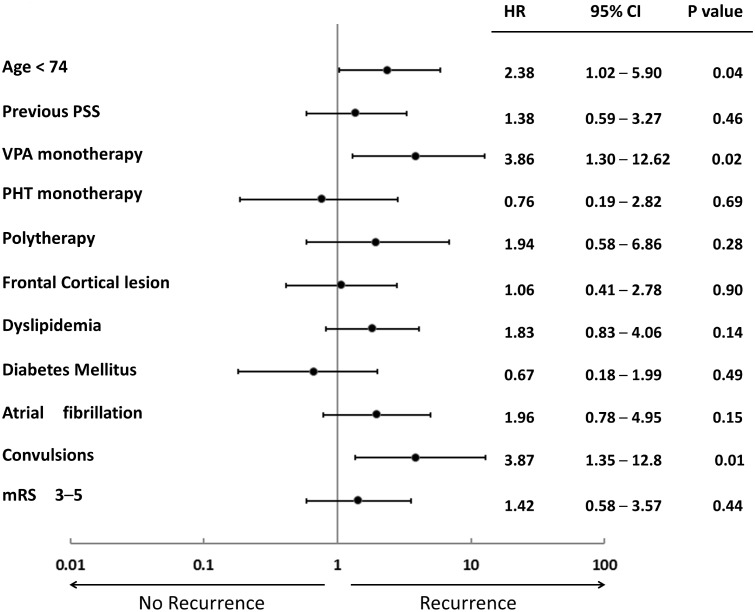
Association of designated factors with presence or absence of recurrent PSS.Hazard ratios (HR) (dots), 95% confidence intervals (95% CI) (error bars), and P values are from Cox proportional hazards models adjusted for age (<74 years), previous post-stroke seizures (PSS), valproic acid (VPA) monotherapy, phenytoin (PHT) monotherapy, polytherapy, frontal cortical lesion, dyslipidemia, diabetes mellitus, atrial fibrillation, presence of convulsions on admission, and poor modified Rankin Scale (mRS) score (3–5).